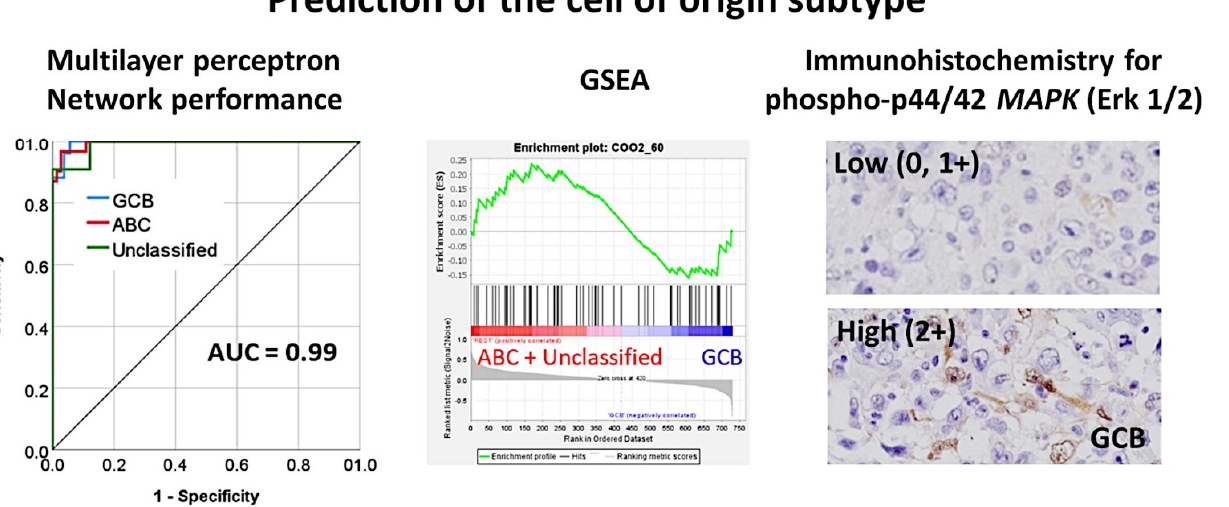
Figure 19. An artificial neural network predicted the overall survival of the diffuse large B-cell lym- phoma patients, and the cell of origin subtype using a pan-cancer immuno-oncology gene expression panel. The analysis consisted of the multilayer perceptron. The cell of origin characterization was assessed with the NanoString Lymph2Cx assay. The performance of the network was high, 0.89 for overall survival and 0.99 for the cell of origin phenotype. GSEA analysis confirmed enrichment toward the survival outcome of the dead and the cell of origin subtype of activated (ABC) + unspecified. Using a risk score formula, with 7 genes it was possible to predict the survival of diffuse large B-cell lymphoma. The association of phospho-MAPK with the germinal center B-cell (GCB) pheno- type was also noted and confirmed by immunohistochemistry. GSEA, gene set enrichment analysis. ABC, activated B-cell type; GCB, germinal center B-cell type.